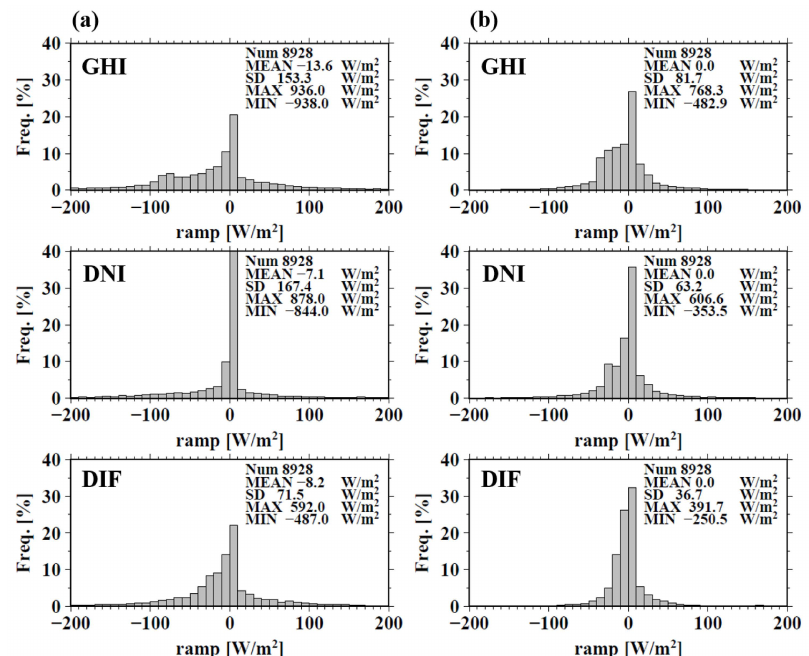
Figure 12. Frequency of solar radiation ramp rate (per 5 min) for ( a ) observations and ( b ) dx500m forecasts in July and August of 2015 at the Tsukuba station. Results for GHI (top), DNI (middle), and DIF (bottom). Num”, “MEAN”, “SD”, “MAX”, and “MIN” in each panel mean data number, mean values, standard deviation, maximum values and minimum values, respectively.